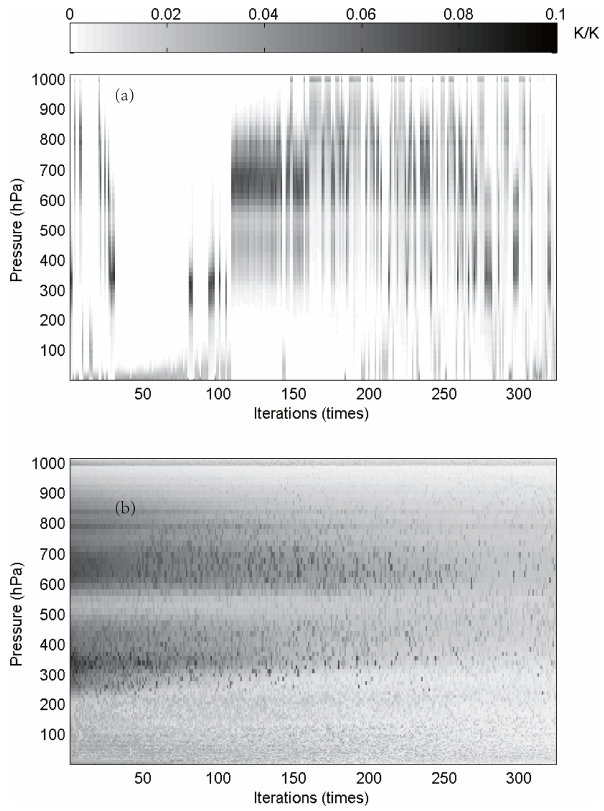
Figure 6. The relationship between the number of iterations and the weighting function of the top 324 selected channels (shaded): (a) ICS and (b)